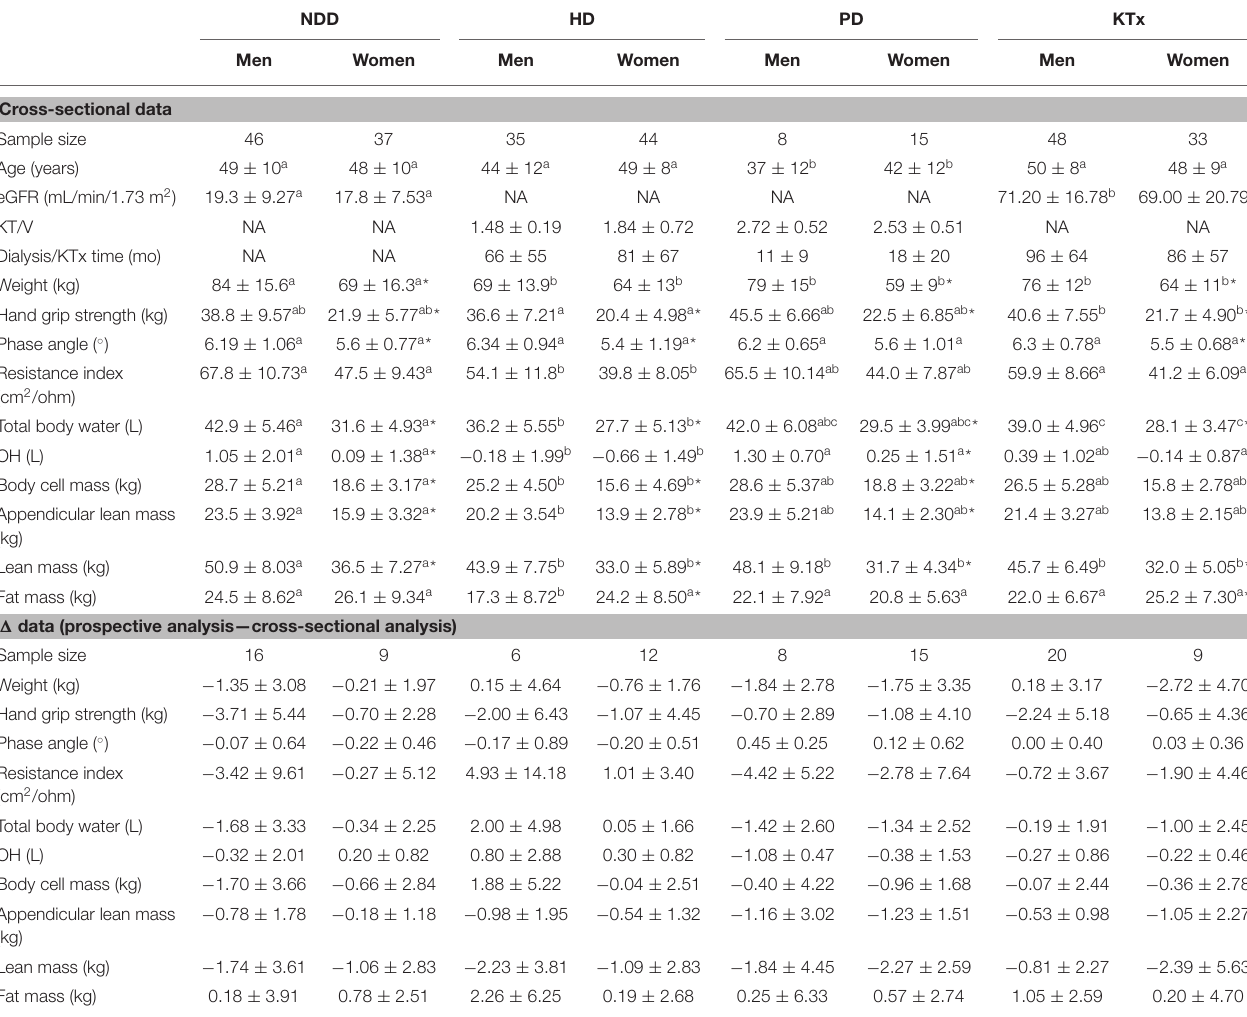
TABLE 1 | Clinical data, anthropometry, BIA and body composition analyze of CKD subgroups stratified by